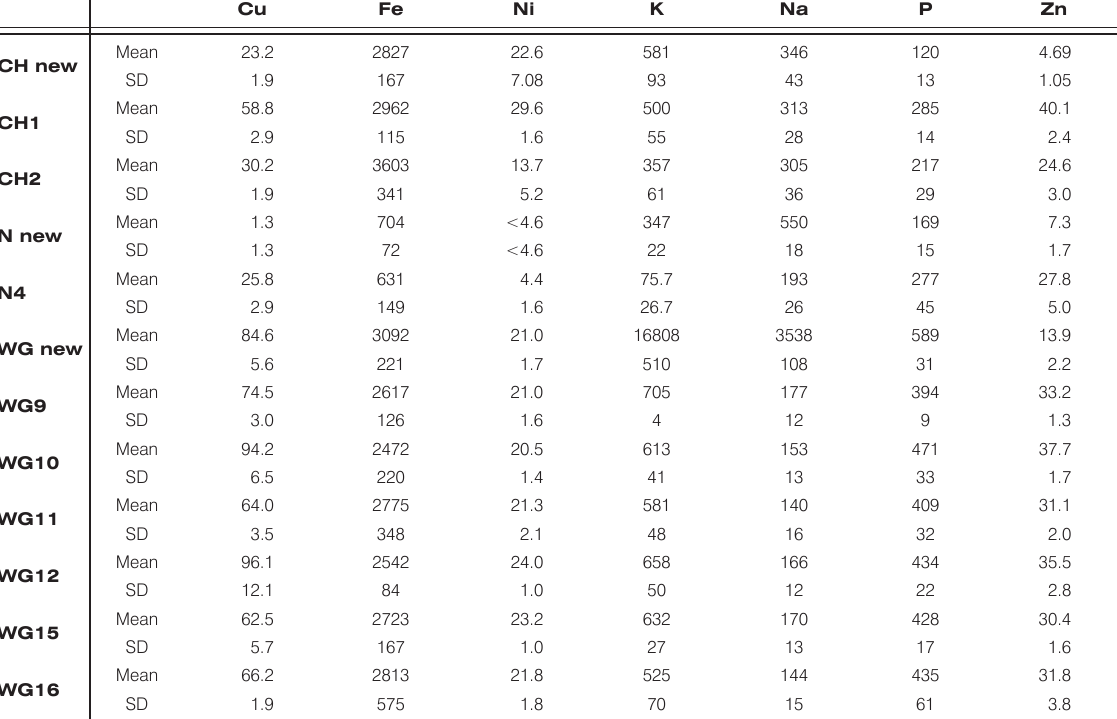
Table 3b. Mean concentration [µg g -1 ] and standard deviation for all samples of activated carbon (n =